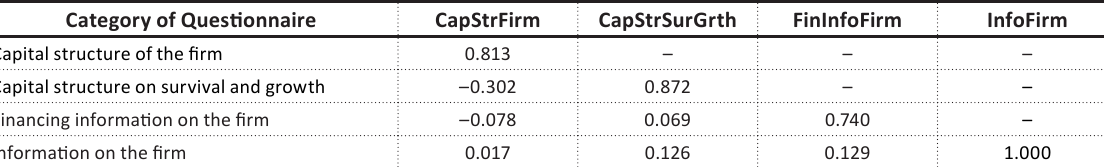
Table 2. Discriminant